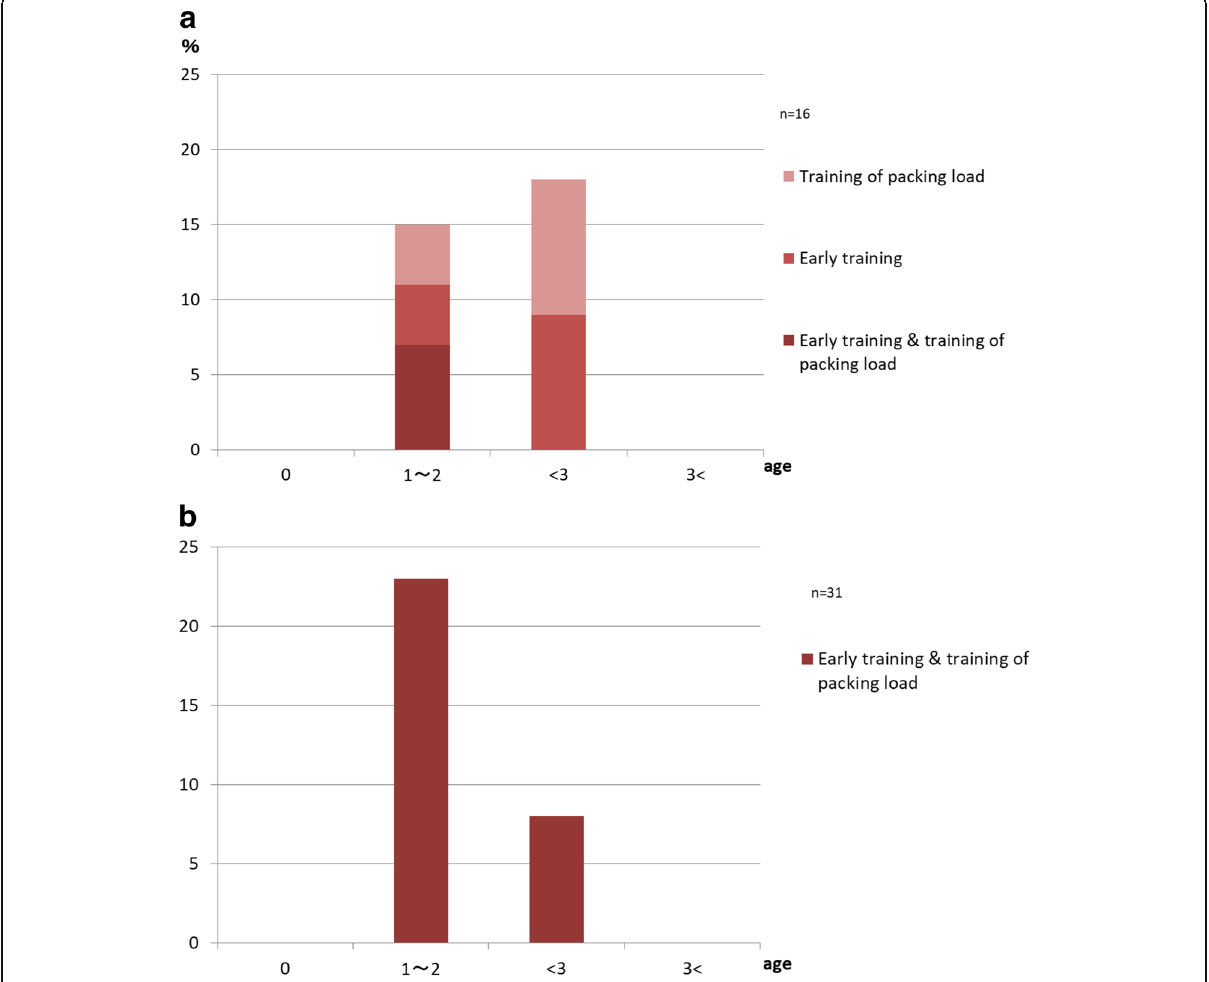
Figure 6 The training ages of donkeys in Afar community. a is the number of responses of Area A. b is the number of responses of Area B. They trained the donkeys in juvenile period (upper 1 to under 3 ages), but Community A had the tendency of separating the early training and the training of packing load. Community B trained these training into as series almost at the same time. ( χ 2 test, p <